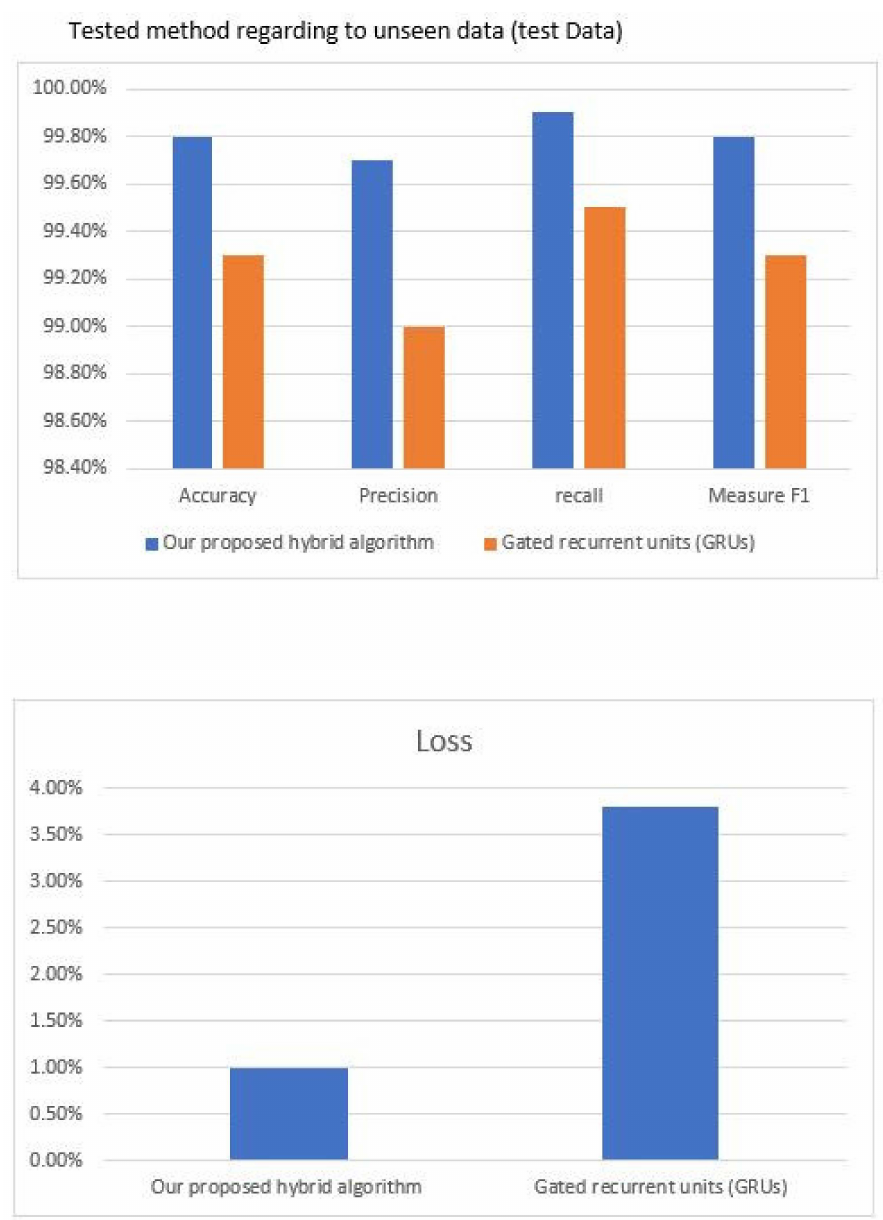
Figure 9. The result or hybrid method with the GRU method regarding the CICDDoS2019